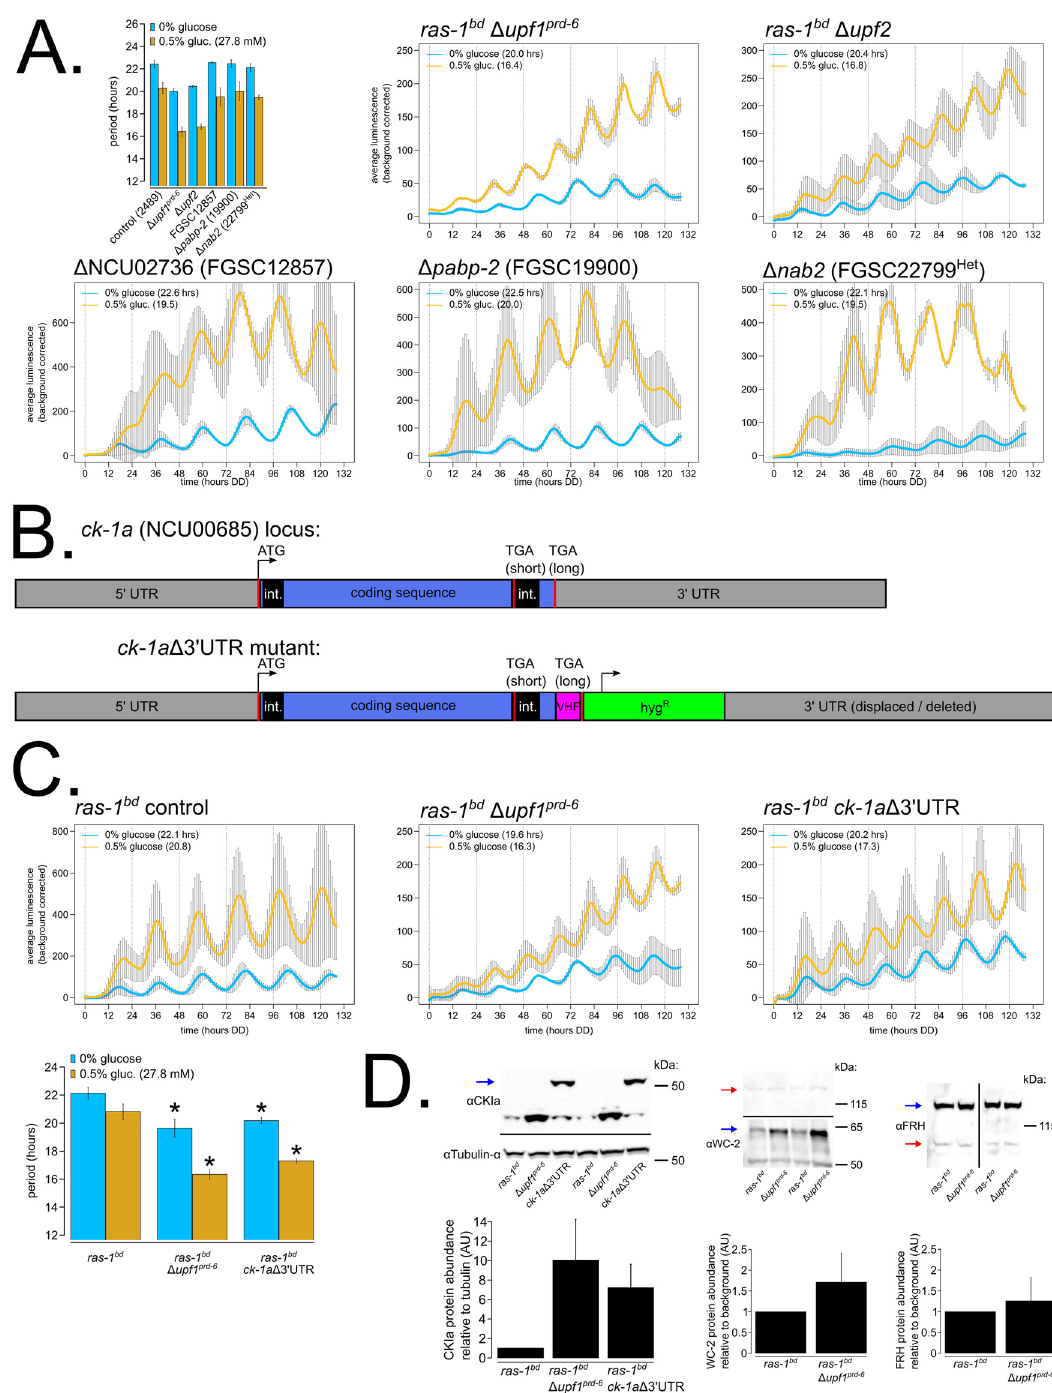
Fig 3. Nutritional under-compensation mutants are enriched for regulators of mRNA stability, and nonsense-mediated decay (NMD) regulation of the casein kinase I 3 0 UTR is required for functional Nutritional Compensation and normal period length. Circadian bioluminescence was recorded from race tube cultures of the indicated deletion mutants. High nutrient medium (yellow lines) contained 0.5% w/v glucose 0.17% w/v arginine, and zero nutrient medium (blue lines) contained 0% glucose 0% arginine (standard deviation error bars). Period lengths were computed ( N � 2 biological replicate period estimates per nutrient concentration) and summarized in a bar graph compared to controls. “Het” indicates heterokaryon strains derived from the Neurospora whole genome deletion collection, which were maintained on hygromycin selection medium prior to the bioluminescence race tube assays ( A ). The CKI 3 0 UTR mutant was constructed by C-terminal epitope-tagging (V5-10xHis-